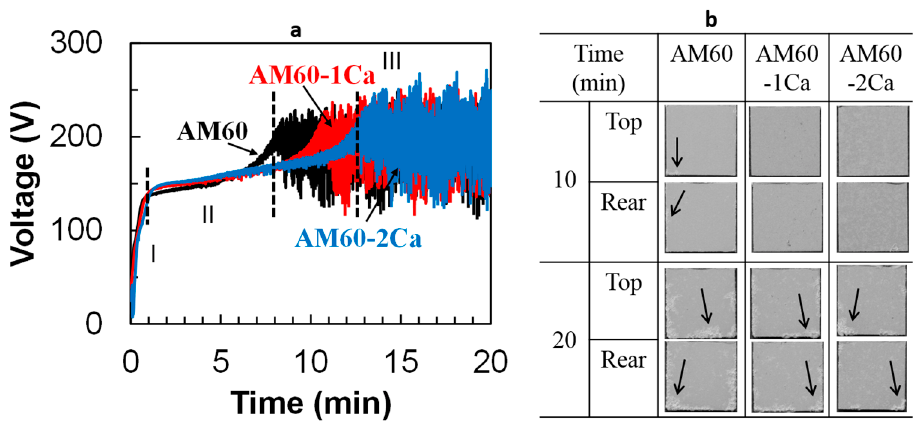
Figure 4. ( a ) Voltage–time curves during anodization of AM60, AM60-1Ca, and AM60-2Ca specimens in 0.5 mol·dm − 3 Na 3 PO 4 solution at 25 °C; and ( b ) the appearance of the specimens after anodization. The areas affected by strong discharge are marked by arrows in image (b).